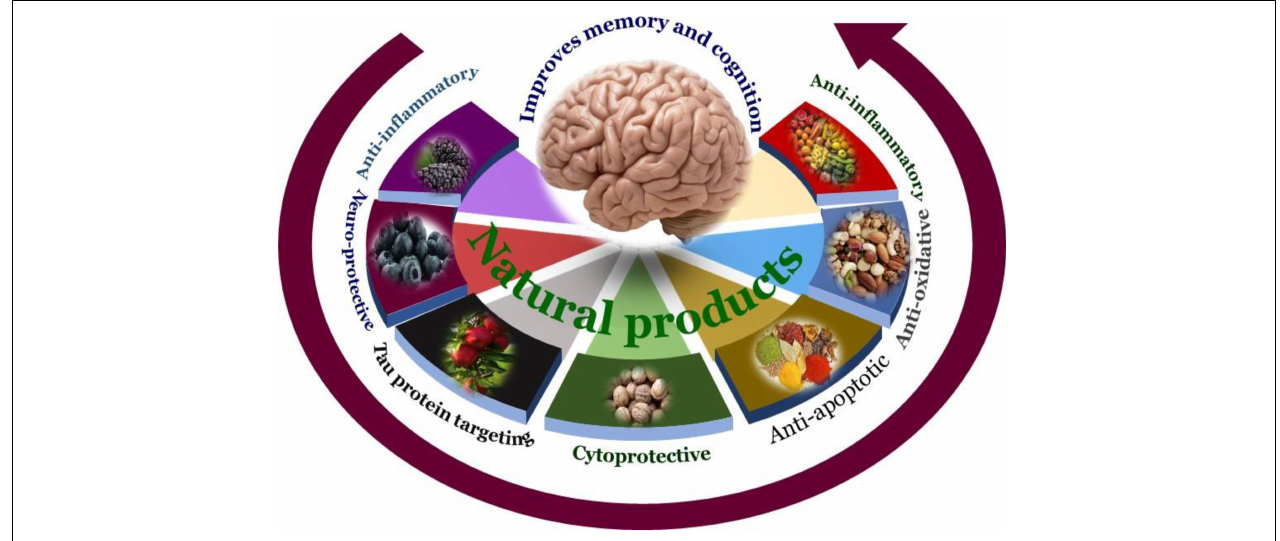
FIGURE 4 | Overview of the natural products’ targets in AD. Many natural products show neuroprotective effects in the various experimental models of AD through multiple mechanisms of action. These include direct effect on neurotoxic agents such as A β plaque formation or tau hyperphosphorylation